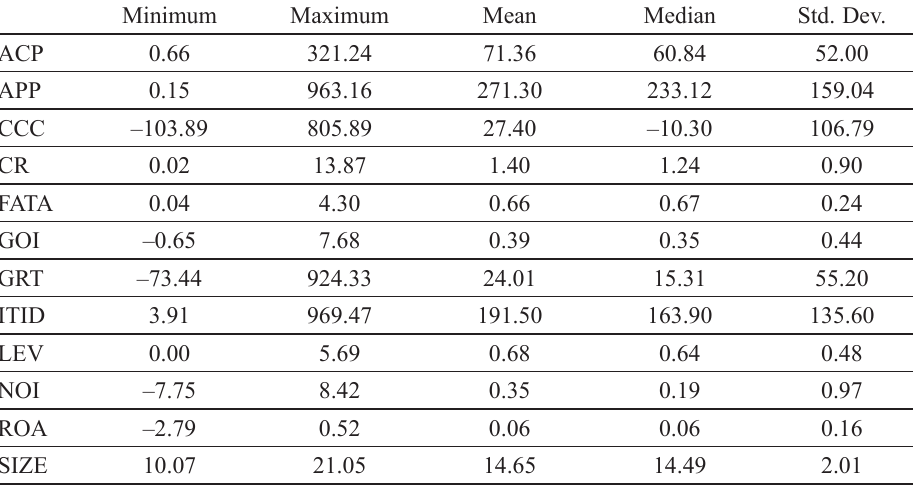
Table 1. Descriptive statistics – 48 listed Nigerian manufacturing firms